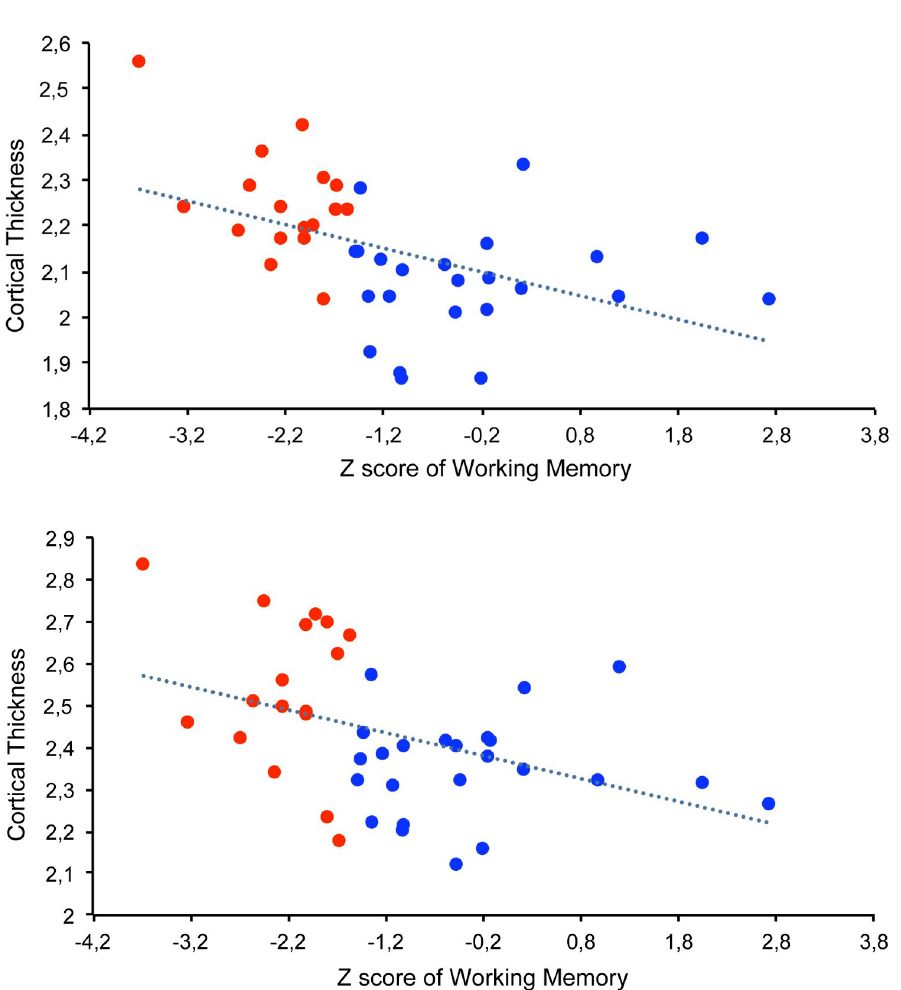
Fig 2. Distribution of cortical thickness (in millimeters) in clusters according to Z scores. Clusters 1 (a) and 2 (b) in HIV-infected patients with (red) and without (blue) working memory deficits.